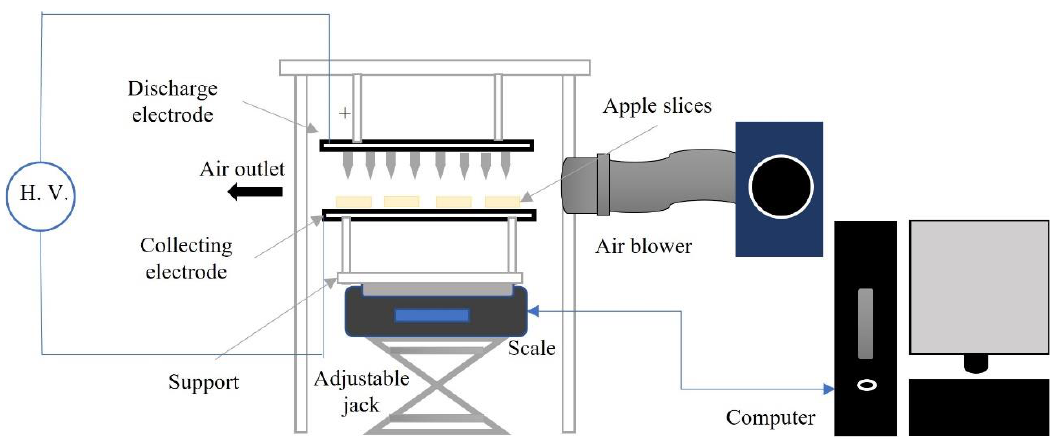
Figure 2. A schematic diagram of the EHD drying setup (H.V. – High